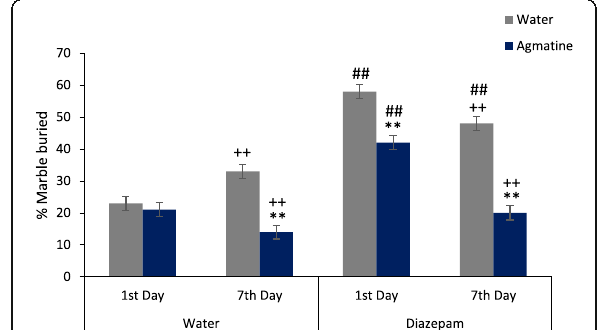
Fig. 5 Marble burying test: Values are expressed as means ± SD (n = 12). Significant differences by Newman-Keuls test: ** p < 0.01 from control group to agmatine-treated groups. ++ p < 0.01, + p < 0.05 from the 1st day administration of water and agmatine. ## p < 0.01